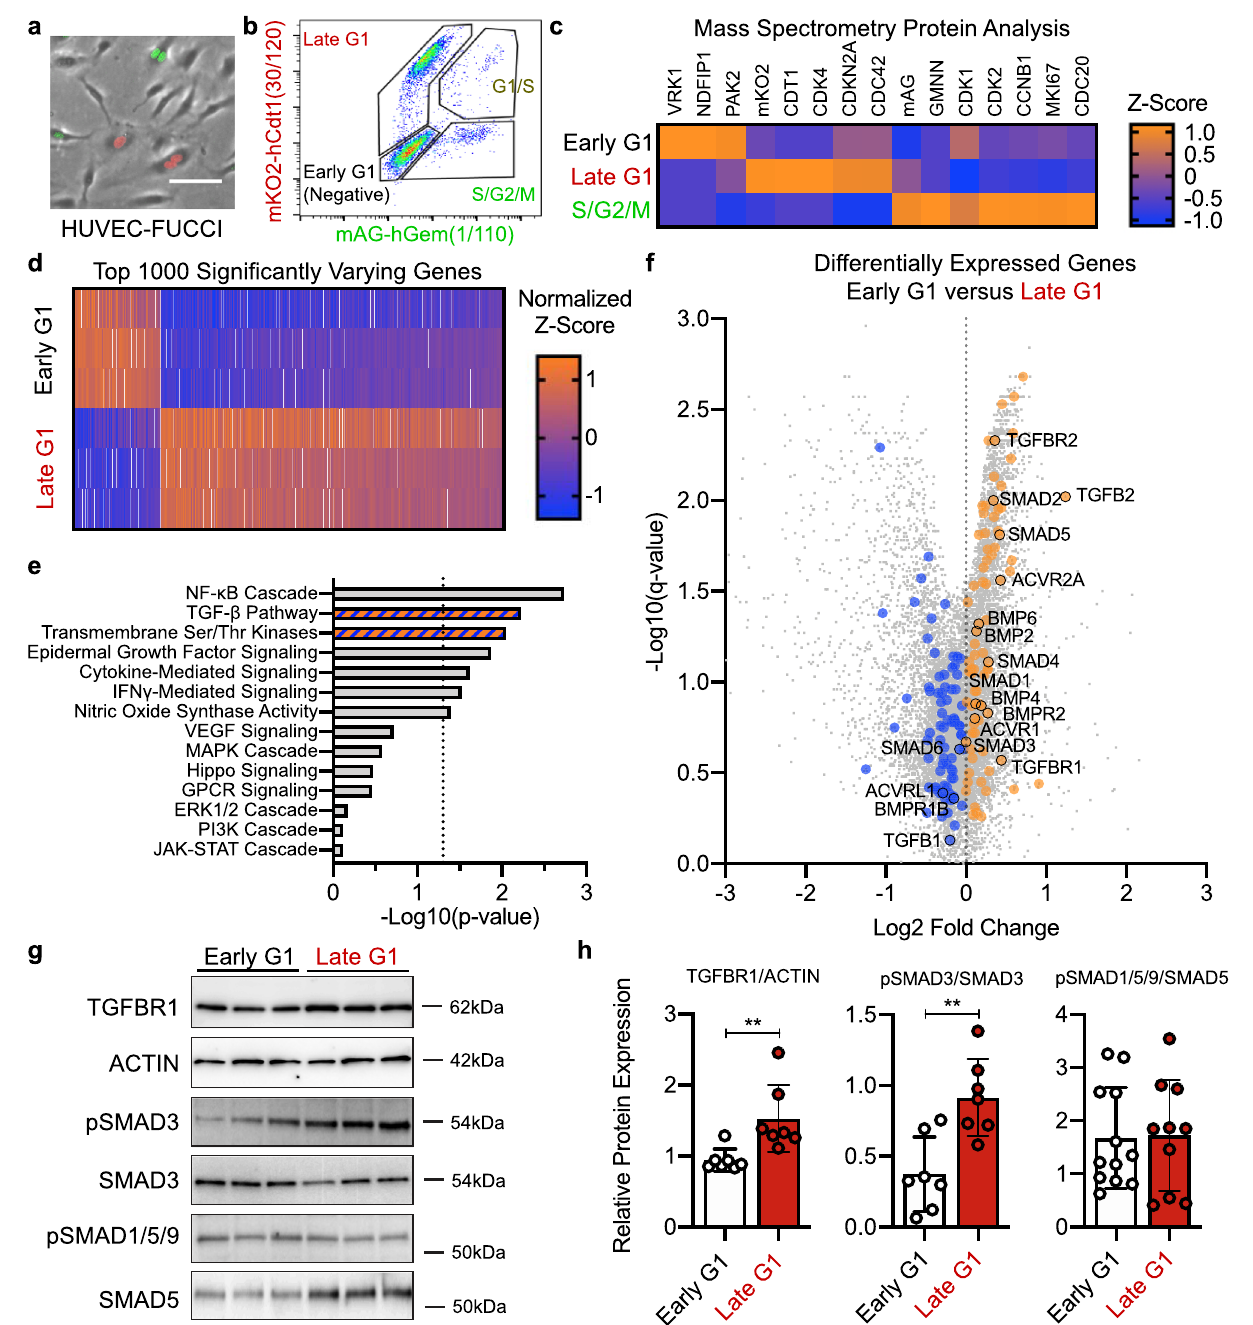
Fig. 5 | Endothelial cell cycle-dependent regulation of TGF- β /BMP pathway. a , b HUVEC-FUCCI reporter distinguishes S/G2/M, early G1 and late G1 cell cycle states, visualized by fl uorescent imaging and FACS. c Differential expression of selected proteins within HUVEC-FUCCI cell cycle states by mass spectrometry analysis.InbulkRNAsequencingofearlyG1andlateG1HUVEC-FUCCI( n =3), d top 1000 signi fi cantly varying genes, e Signaling Pathway GO Term analysis (statistical analysisreportedfromGAGEpipelineas p -value),and f Volcanoplotoffold-change against the log10(q-value) (TGF- β /BMP signaling pathway genes highlighted,